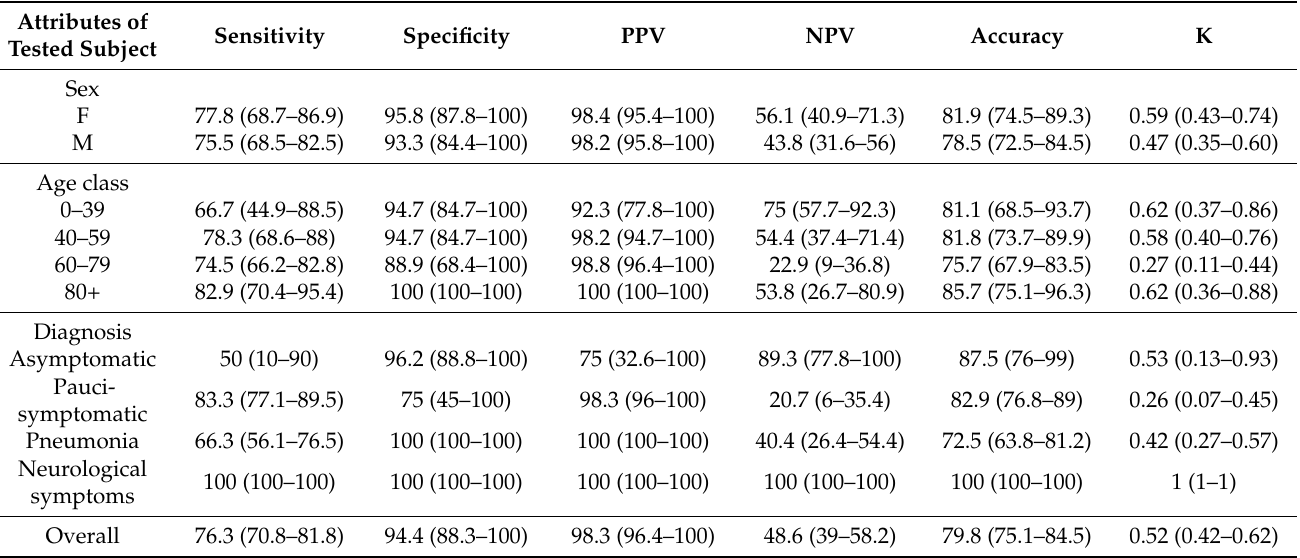
Table 2. Sensitivity, specificity, positive predictive value, negative predictive value, and accuracy of LumiraDx™ test, in accordance with patients’